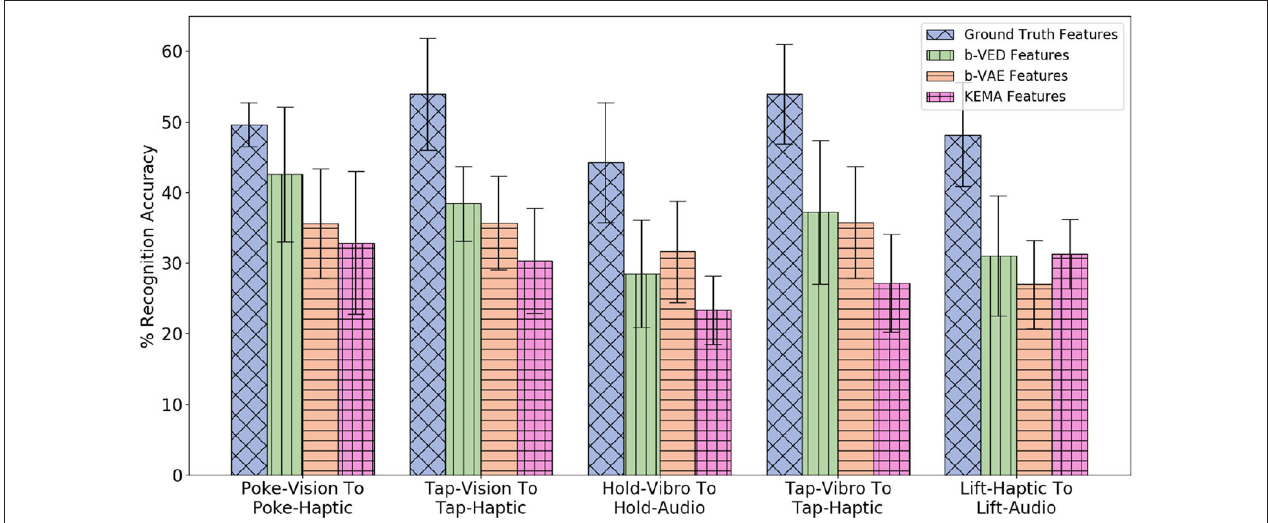
FIGURE 10 | β -VED cross-perception projections where the Accuracy Delta is minimum and corresponding β -VAE projections and KEMA